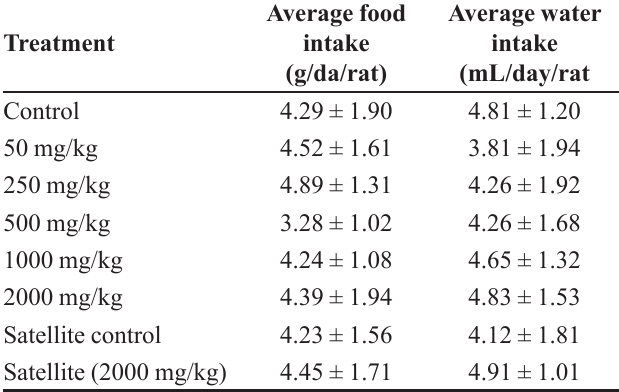
TABLE II - Effect of AERI on food intake and water consumption by rat during 28 days treatment and recovery period (satellite